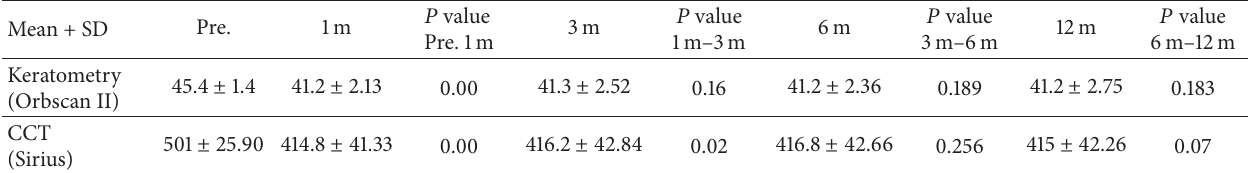
Table 3: Changes in keratometry and central corneal thickness over time.